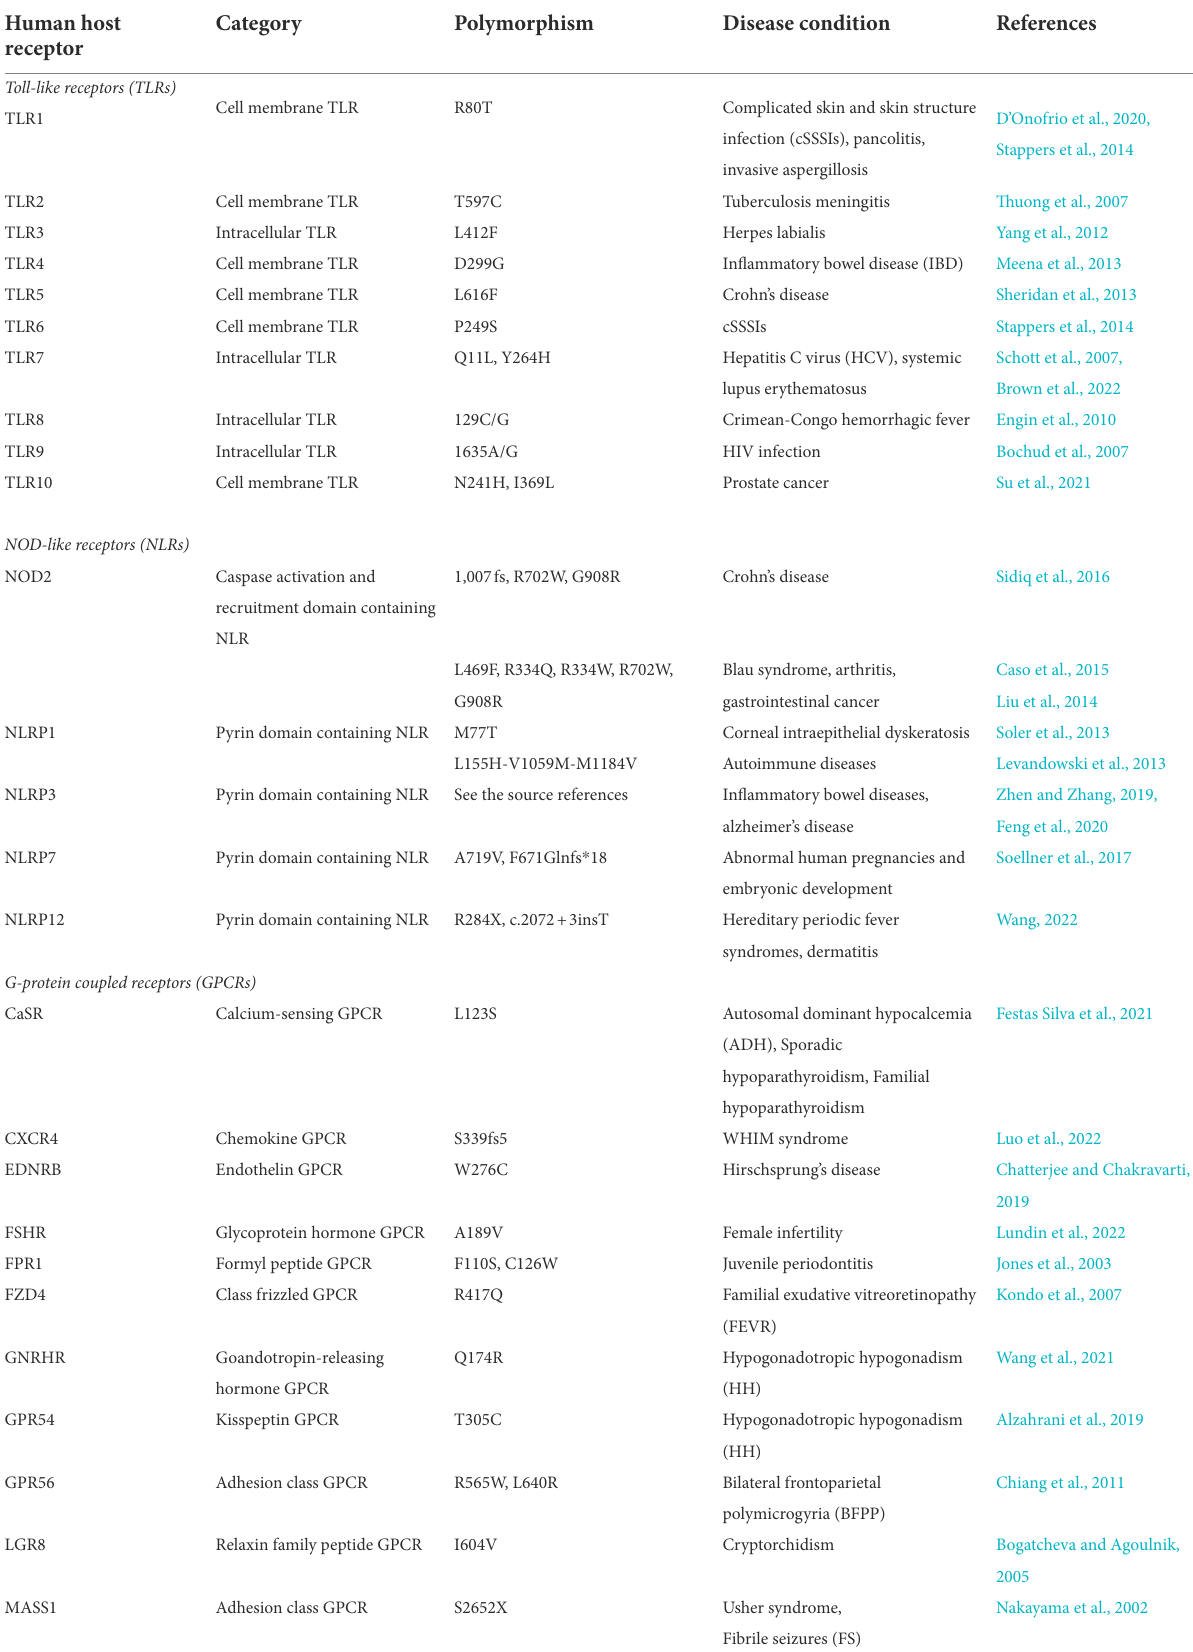
TABLE 1 Table showing important examples of human host receptors, their polymorphisms and their associated